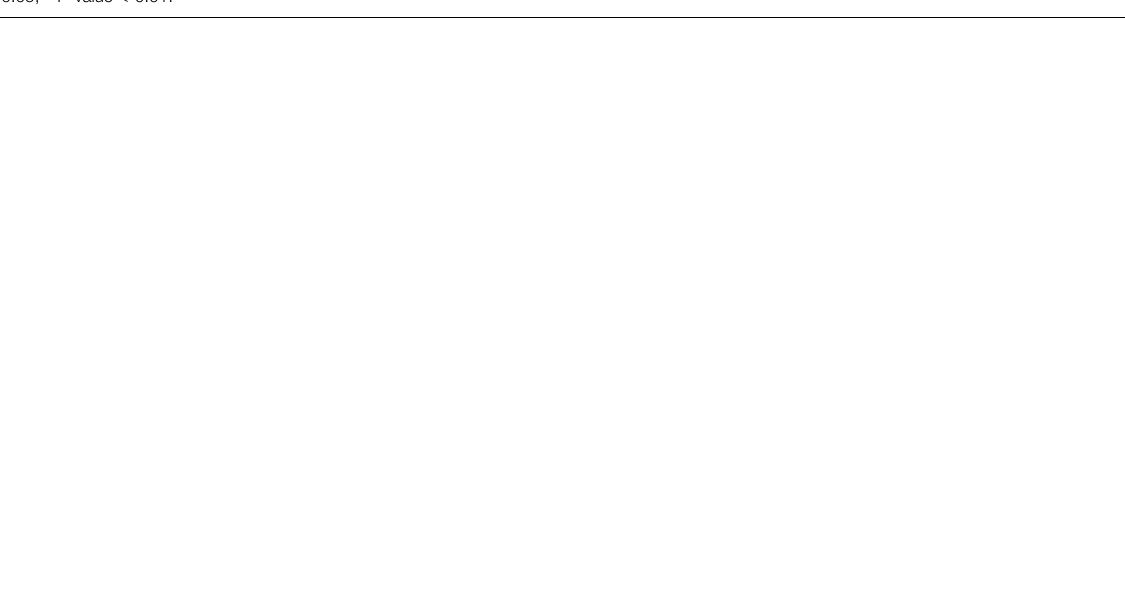
FIGURE4| Melatoninincreasedcitratethroughup-regulatingZIP-1inosteoblasts. (A) polymerasechainreactionresultsofZIP-1knockdownandoverexpression, (B) western blotting results of ZIP-1 (34 kDa) knockdown and overexpression, (C) relative expression value of ZIP-1, and (D) citrate content in osteoblasts, *P-value < 0.05, **P-value <